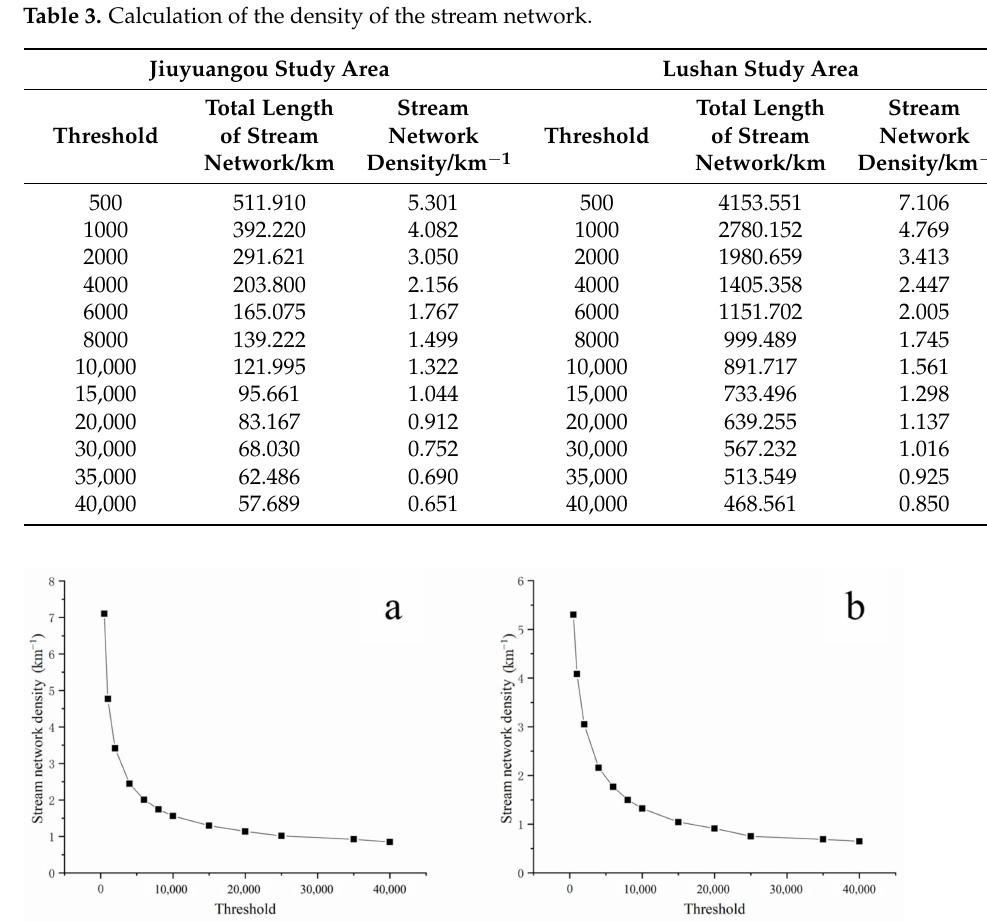
Figure 10. Relationship curve between stream network density and critical catchment area: ( a ) Jiuyuangou study area; ( b ) Lushan study